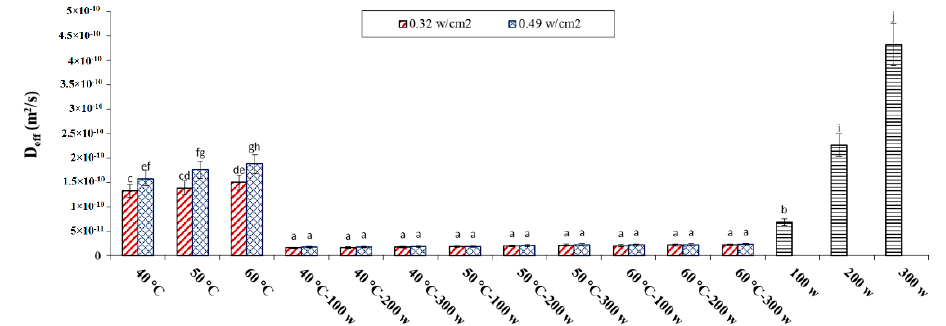
Figure 2. The values of D eff versus air temperature (°C), different infrared radiations (W) and microwave power (W) for rice drying under different dryers. Note: The same letter over column shows that the mean amount had no significant difference ( p < 0.05) based on Duncan’s test. The error bars represent standard error of the means.